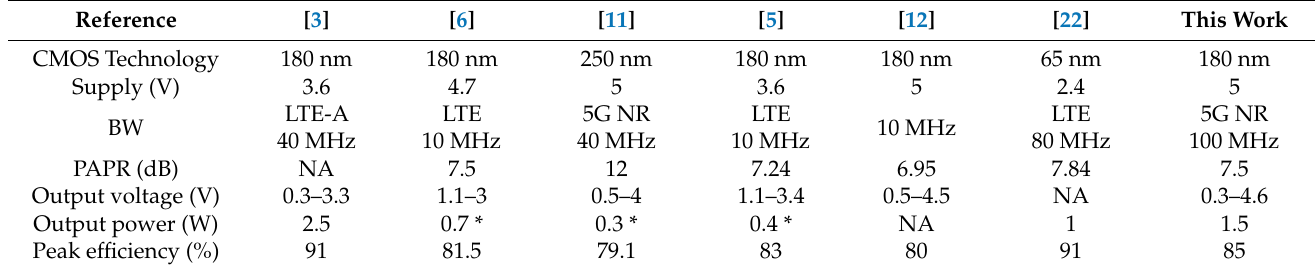
Table 3. Performance comparison with the prior arts.